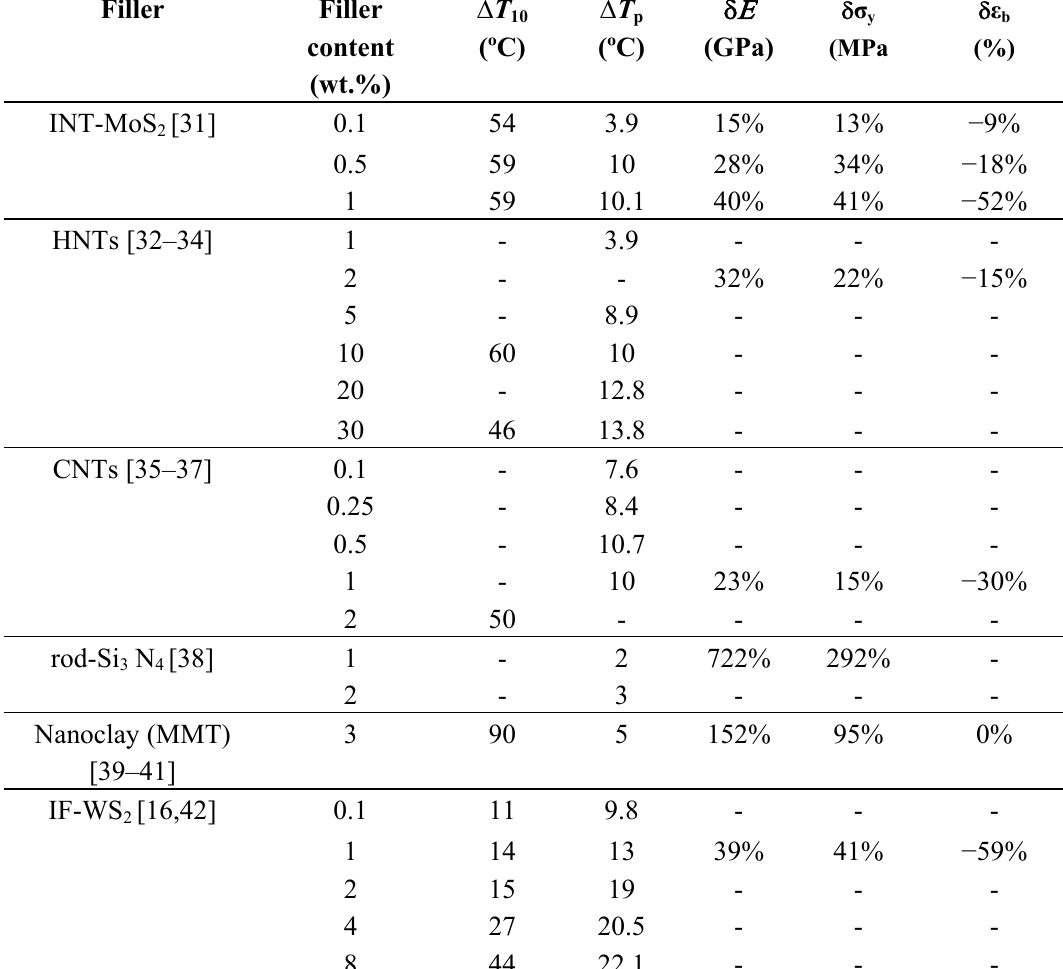
Table 1. Thermal stability, crystallization, and mechanical data for isotactic polypropylene (iPP) nanocomposites using nanoreinforcing fillers with different morphologies (e.g., tubular, spherical and laminar-like particles) taken from literature. ∆ T = increment of 10 degradation temperature for 10% weight loss, ∆ T = increment of crystallization peak p temperature,  E = Percentage variations of Young’s modulus,  σ = Percentage variations y of tensile strength and  ε = Percentage variations of strain at b